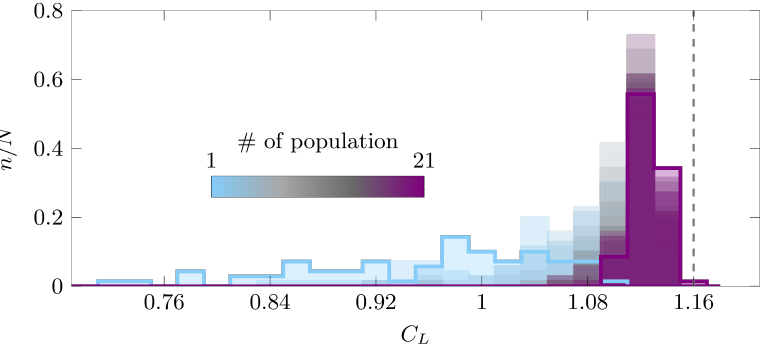
Figure 7. Distribution of the stroke average lift coefficient for the 21 populations tested in the lift optimization scenario. The colors indicate the number of the population, which all included N = 70 individuals. The vertical dotted line indicates the maximal stroke average lift coefficient reached by the final optimized solution. The distributions of the first and final population are highlighted by increased line